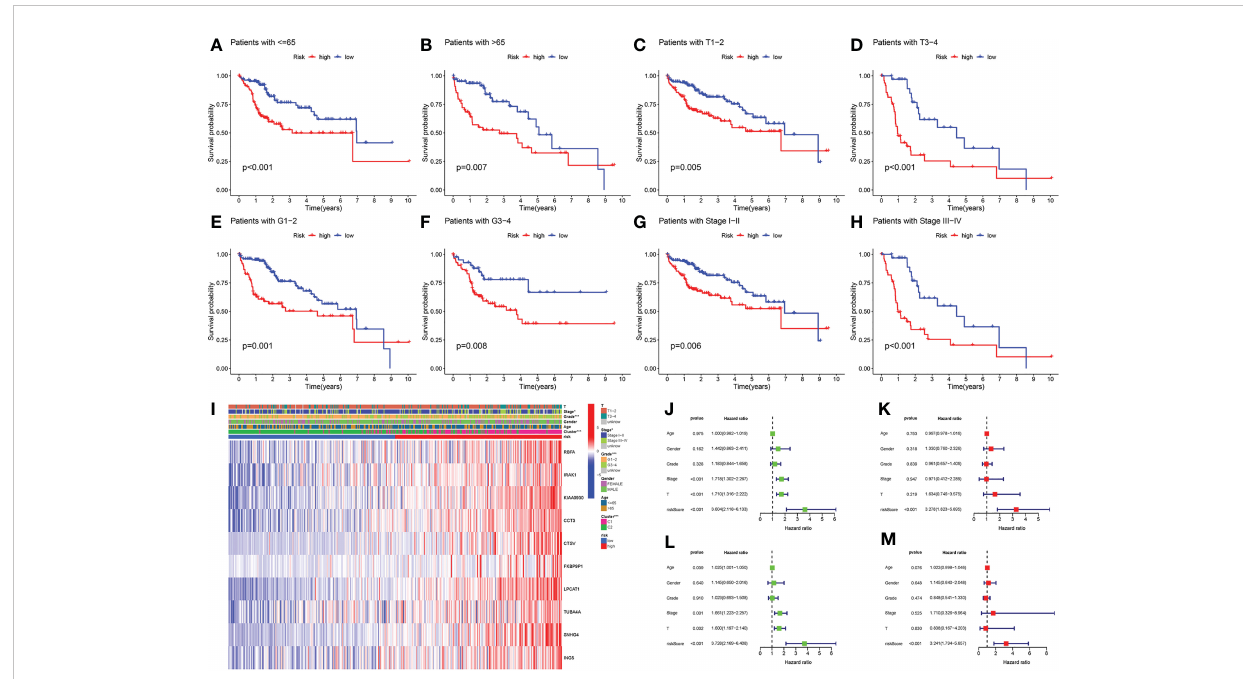
FIGURE 7 Clinical analyses of the prognostic signature. (A) LIHC patients with ≤ 65. (B) LIHC patients with > 65. (C) LIHC patients with T1-T2. (D) LIHC patients with T3-T4. (E) LIHC patients with G1-G2. (F) LIHC patients with G3-G4. (G) LIHC patients with stage I-II. (H) LIHC patients with stage III-IV. (I) Distributions of clinicopathological parameters between the low-risk group and the high-risk group. (J) Univariate Cox regression analysis of risk score in TCGA cohort. (K) Multivariate Cox regression analysis of risk score in TCGA cohort. (L) Univariate Cox regression analyses of risk score in ICGC cohort. (M) Multivariate Cox regression analysis of risk score in ICGC cohort. * P -value < 0.05, *** P -value <